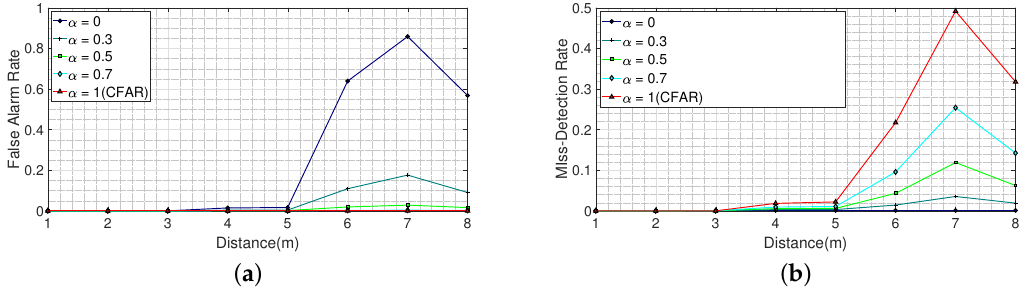
Figure 18. False alarm rate and miss-detection rate in a heavy clutter environment according to α . ( a ) False alarm rate according to α . ( b ) Miss-detection rate according to α